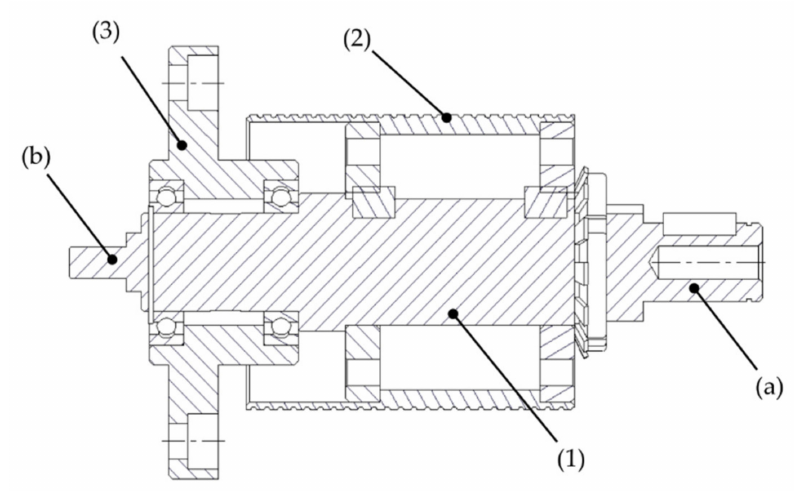
Figure 4. Pulley system assembly: (1) shaft; (2) pulley body; (3) bracket; (a) end of the shaft for connection of link module; (b) end of the shaft for encoder